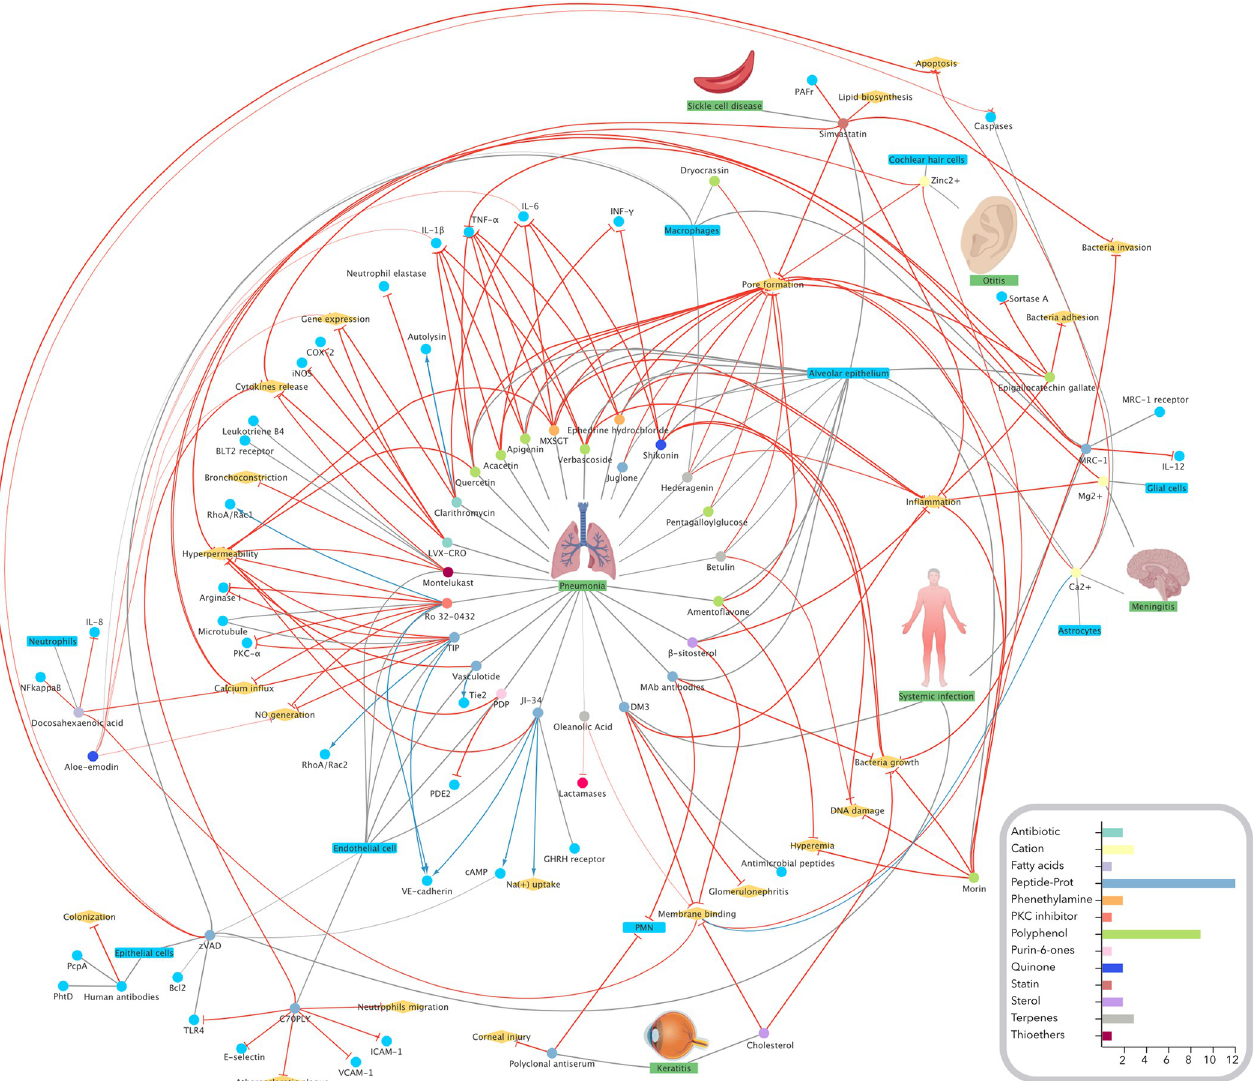
Fig 3. Knowledge network of the protective molecules against PLY. PLY interactions (edges) with host molecules (cyan circles), cells (cyan rectangles), and cellular processes (orange diamonds) is shown. Three types of connections are distinguished: the red arrows indicate inhibition ( ⟂ ) whereas the blue arrows refer to activation ( " ) and the grey arrows show interactions without inhibition or activation. The width of the lines reflects article ranking. The right panel represents the abundance and color of the molecules grouped by type. The network was built using Cytoscape software after text mining articles with EXTRACT